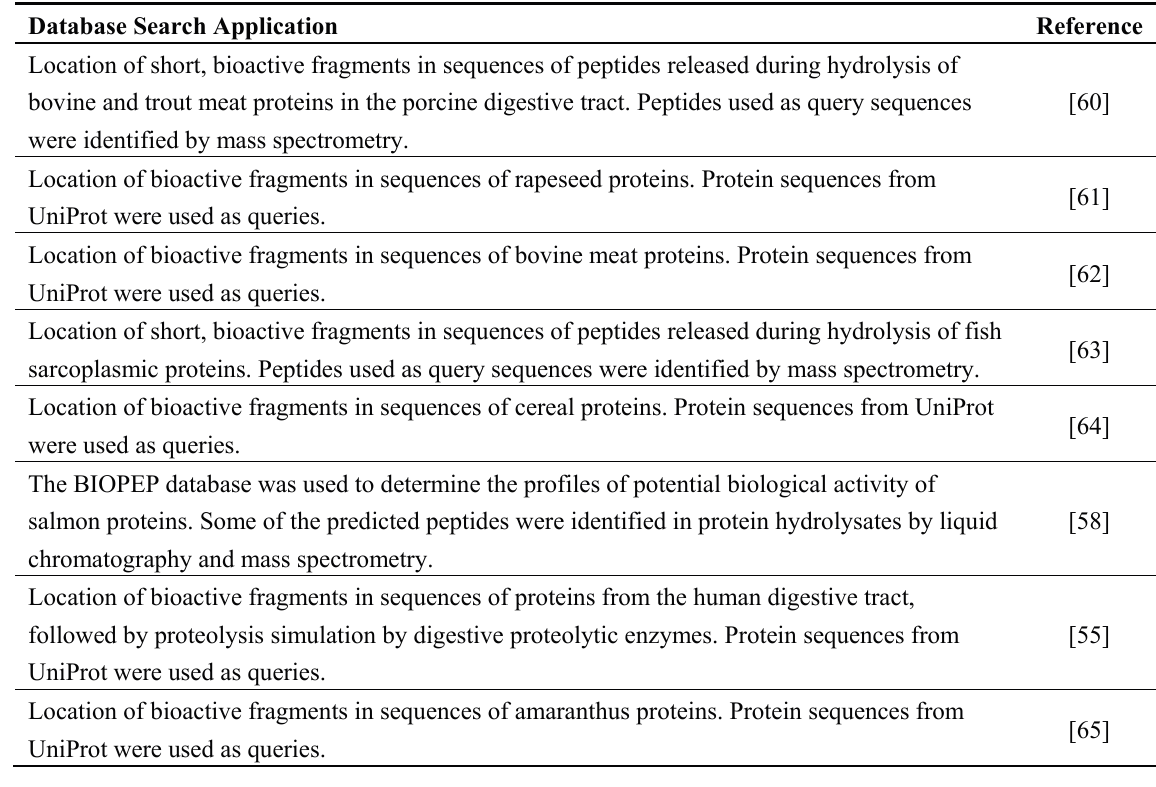
Table 2. Examples of protocols involving the search for shorter fragments in sequences of proteins or peptides relevant for food and/or nutrition sciences.